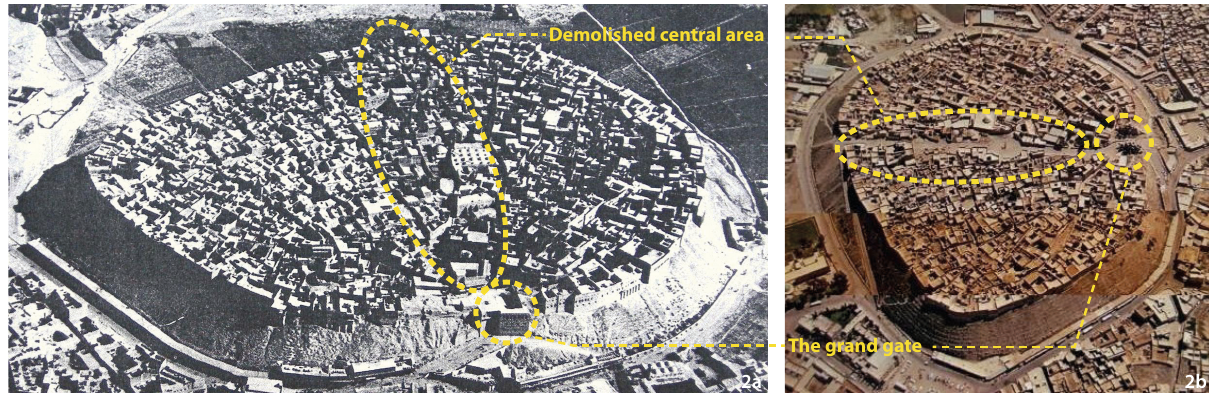
Figure 2a The Citadel in 1951, before the renovation (Source: Brammah). Figure 2b The Citadel after 1979, after the renovation (Source: